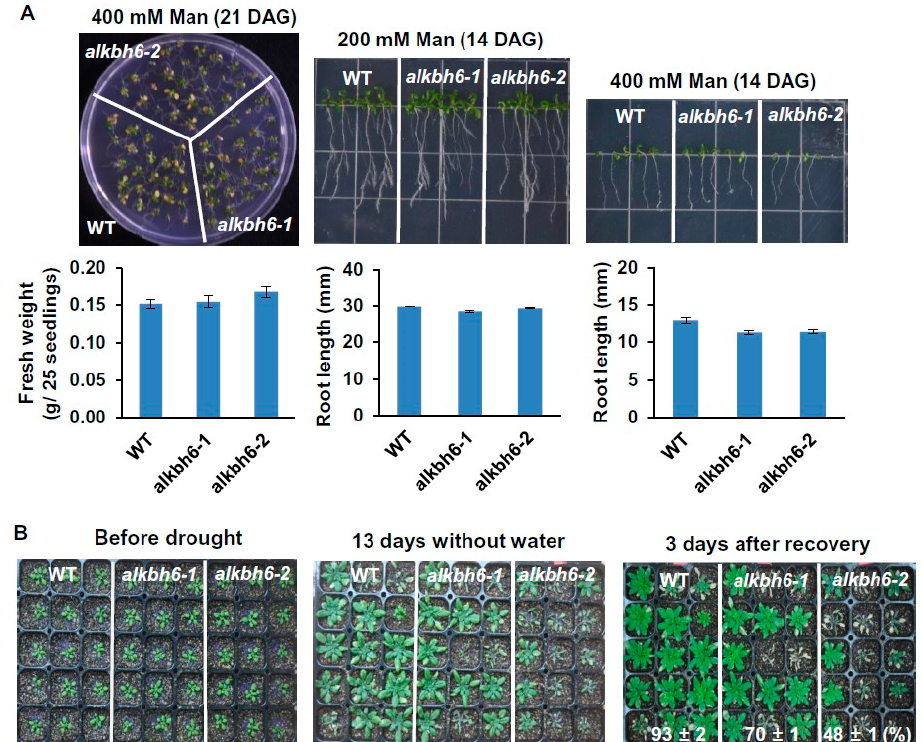
Figure 2. Seedling and root growth of the alkbh6 mutants under drought stress. ( A ) The wild-type (WT) and alkbh6 mutants were grown on the (Murashige and Skoog) MS medium supplemented with 200 or 400 mM mannitol, and the fresh weight and root length of the seedlings were measured at the indicated days after germination (DAG). ( B ) Twenty-day-old seedlings grown in soil were subjected to drought stress for 13 days, and survival rates were measured 3 days after recovery. Values are the mean ± SE obtained from three independent experiments.